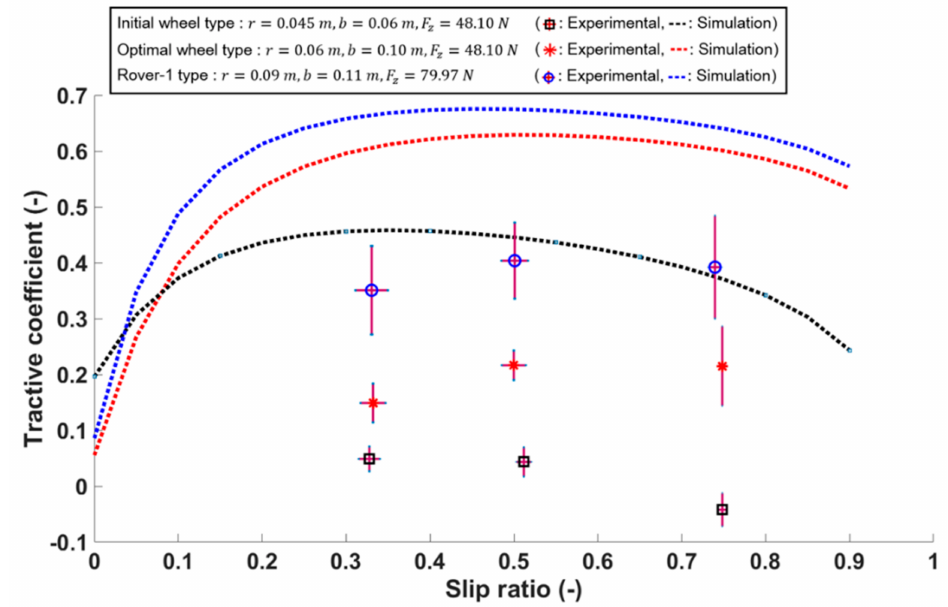
Figure 20. Comparison of experimental and simulated results for tractive coe ffi cient according to slip ratio and di ff erent axle load, for initial wheel type, optimal wheel type, and rover-1